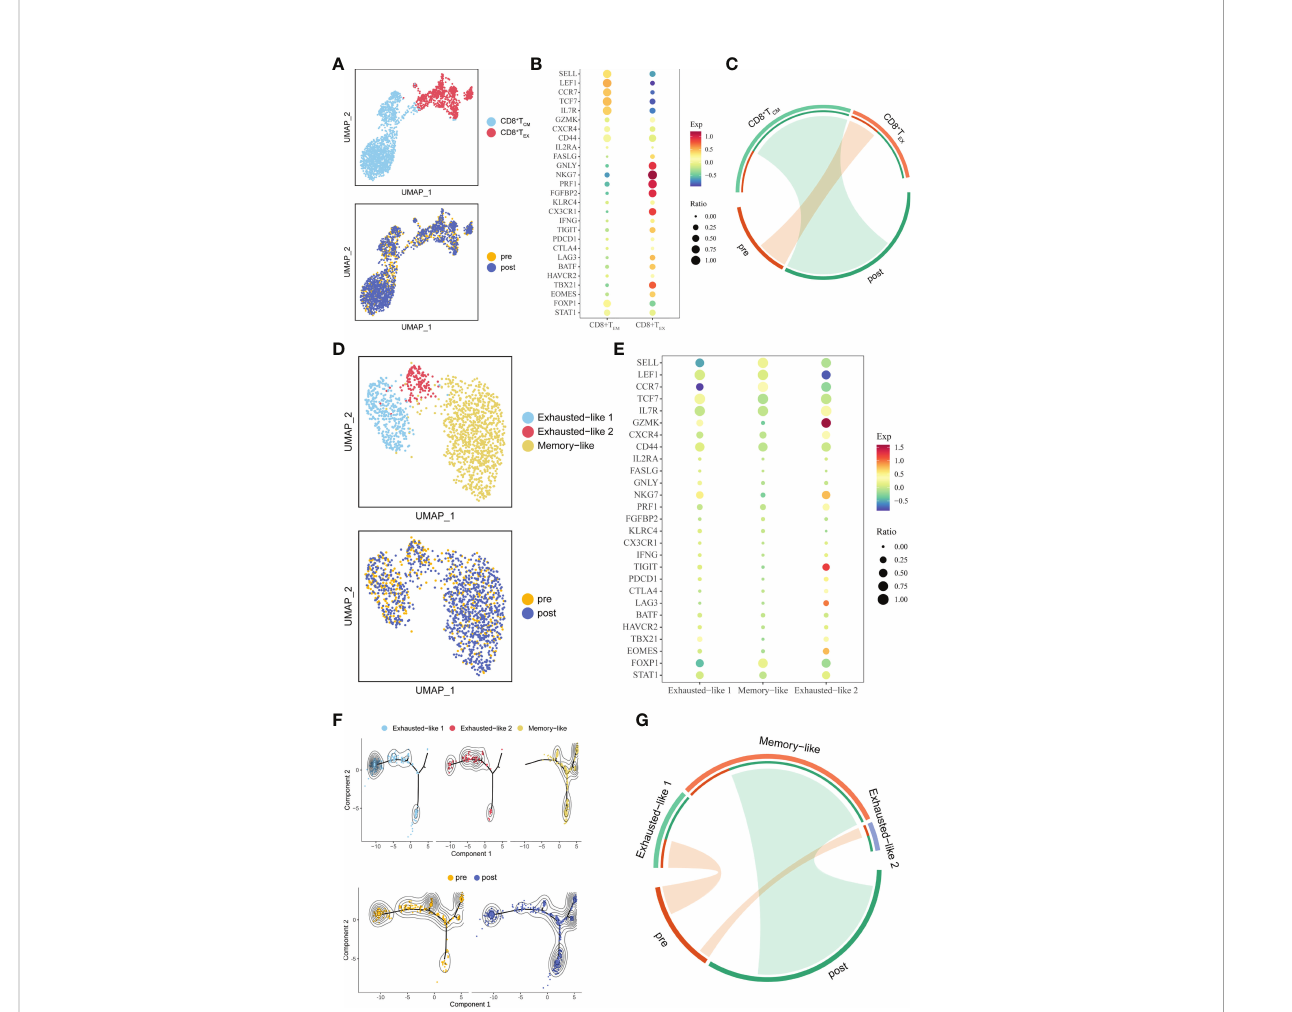
FIGURE 3 Detailed characterization of CD8 + T cells and their association with treatment. (A) UMAP of all CD8 + T cells, colored by cell type and sample. (B) Bubble plot of selected CD8 + T cell function-associated genes in each cell cluster. (C) The association between subtypes and treatment in CD8 + T cells. The area of the ties represents the relative enrichment. (D) UMAP of all CD8 + T CM cells, colored by cell type and sample. (E) Bubble plot of selected CD8 + T CM cells function-associated genes in each cell cluster. (F) Pseudotime analysis of CD8 + T CM cells derived from PBMC samples inferred by Monocle2. Each point corresponds to an individual cell colored by cluster (above) or by treatment (down). The density curves represent the distribution of each cluster. (G) The association between subtypes and treatment in CD8 + T CM . The area of the ties represents the relative